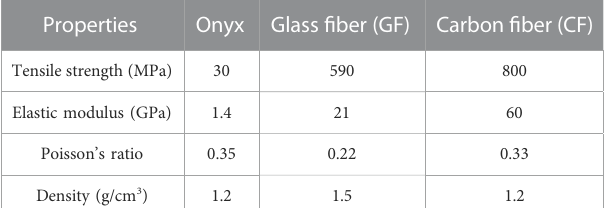
TABLE 1 Material